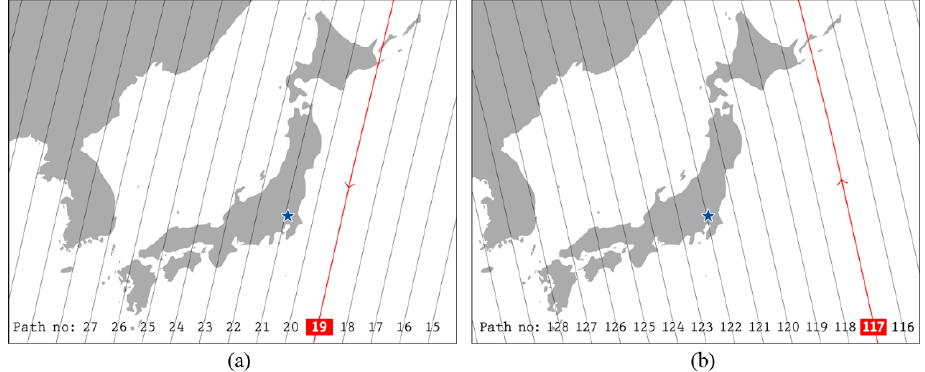
Figure 8. Orbital paths of ALOS-2: ( a ) descending and ( b ) ascending. Blue stars represent the affected area of the 2015 Joso flood (36.0 ◦ N, 140.0 ◦ E) in Japan. Table 6. Observation opportunities of ALOS-2 for the Joso area, Japan, in descending (D) and ascending (A) paths.